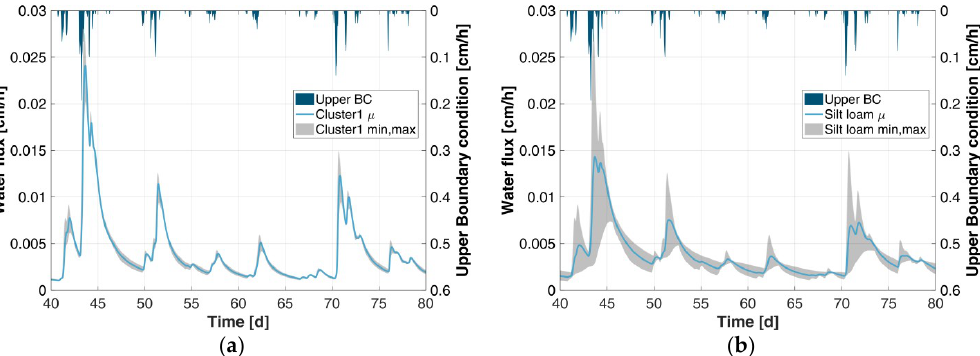
Figure 4 . ( a ): Representative time series of cluster 1 of the classification based on hydraulic behaviour (blue line) for the dynamic boundary condition. Further, the minima and maxima out of all class members are shown for each time step (grey area). ( b ): The same analyse for the class members of “silt loam” of the USDA classification.